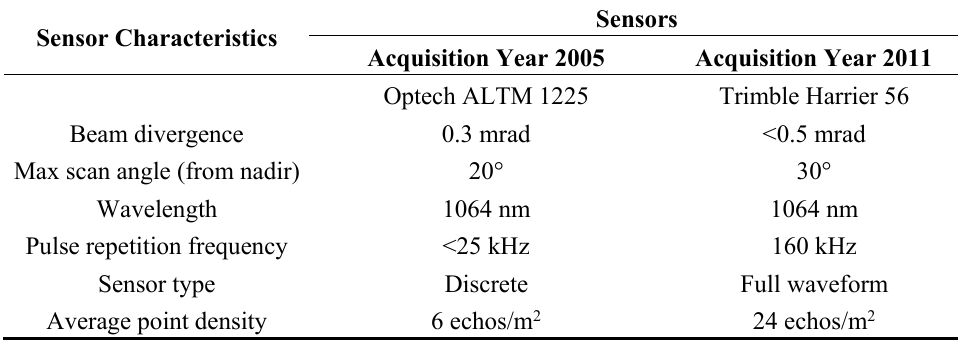
Table 1. Summary of sensor characteristics of the applied ALS